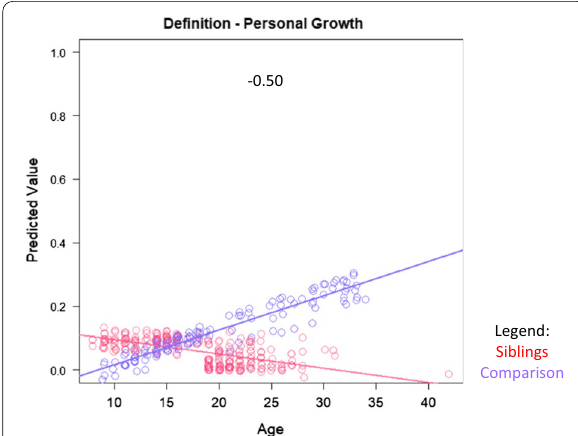
Fig. 3 Interaction plots for adjusted logistic models predicting QOL definition themes . Role-group differences for medium- and large-ES interaction effects are shown. Sibling predicted values are shown in red; comparison in blue